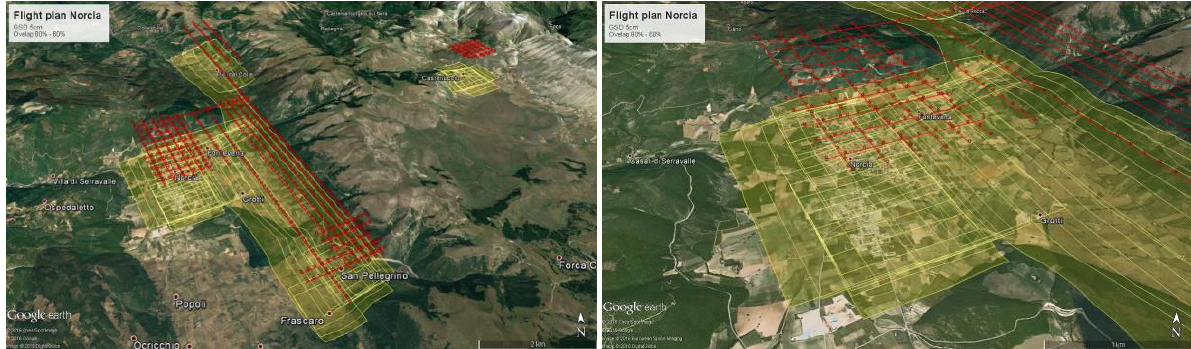
Figure 3. Flight plan of Norcia project. Left: overall plan, including Norcia and Castelluccio di Norcia. Right: detailed plans for Norcia historic centre.